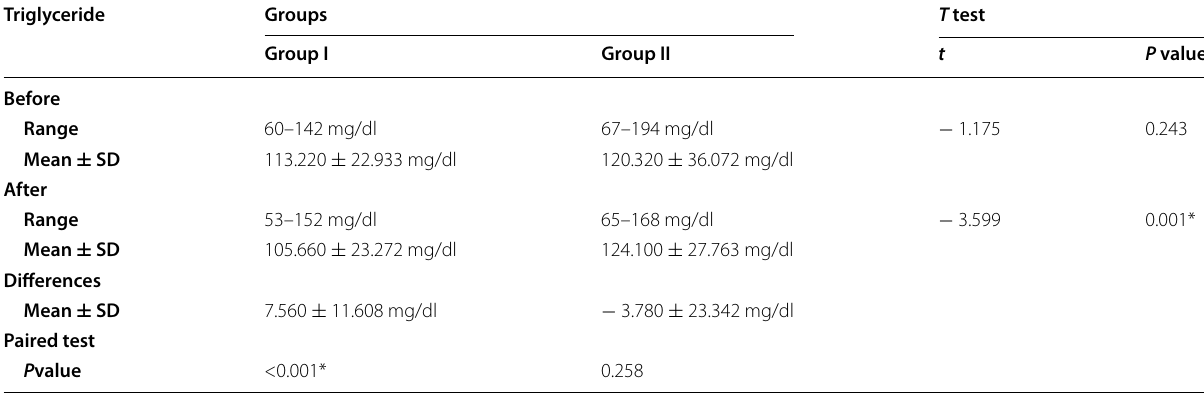
Table 4 Comparison between each group before and after treatment and the two studied groups according to triglyceride level